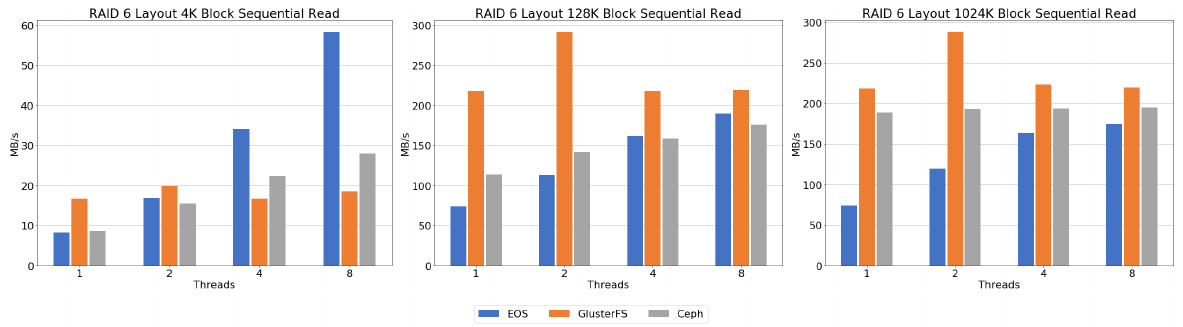
Figure 14. RAID 6-like layout—sequential read